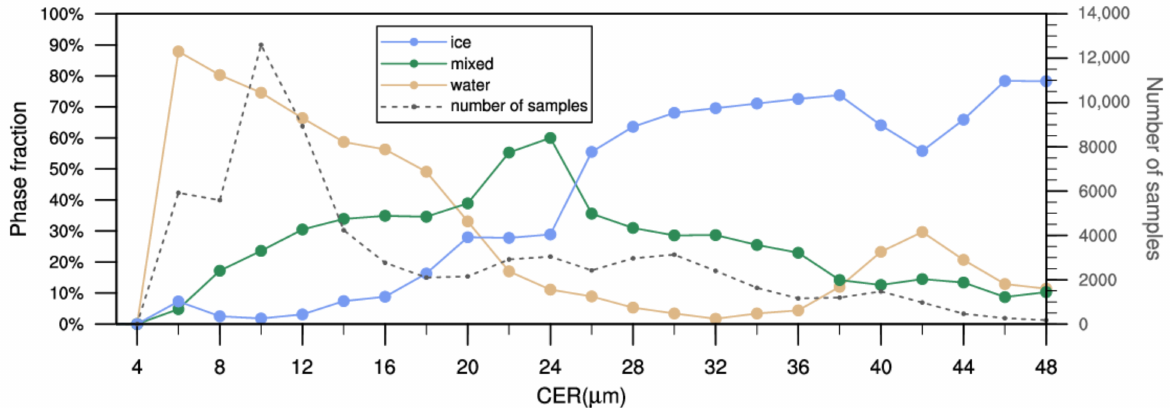
Figure 10. Variations of fraction of water, mixed, and ice clouds with the cloud effective radius. The gray dashed line represents the number of samples. CER = cloud effective